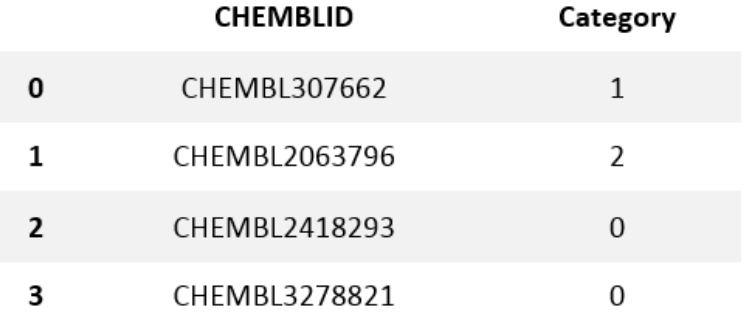
Figure 10. Transfer Learning vgg16 was applied for molecular feature extraction.